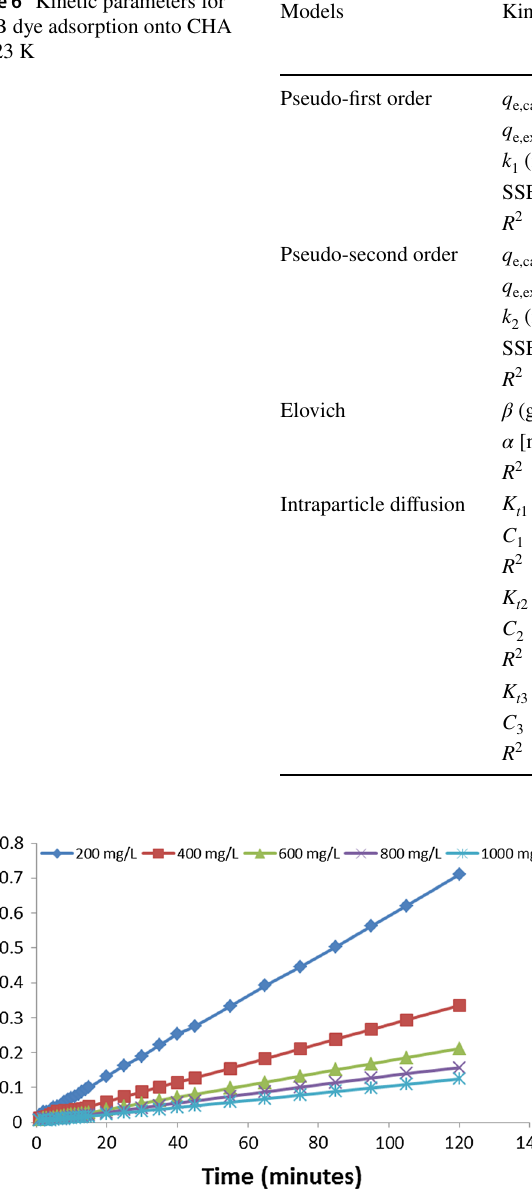
Table 6 Kinetic parameters for Rh-B dye adsorption onto CHA at 323 K